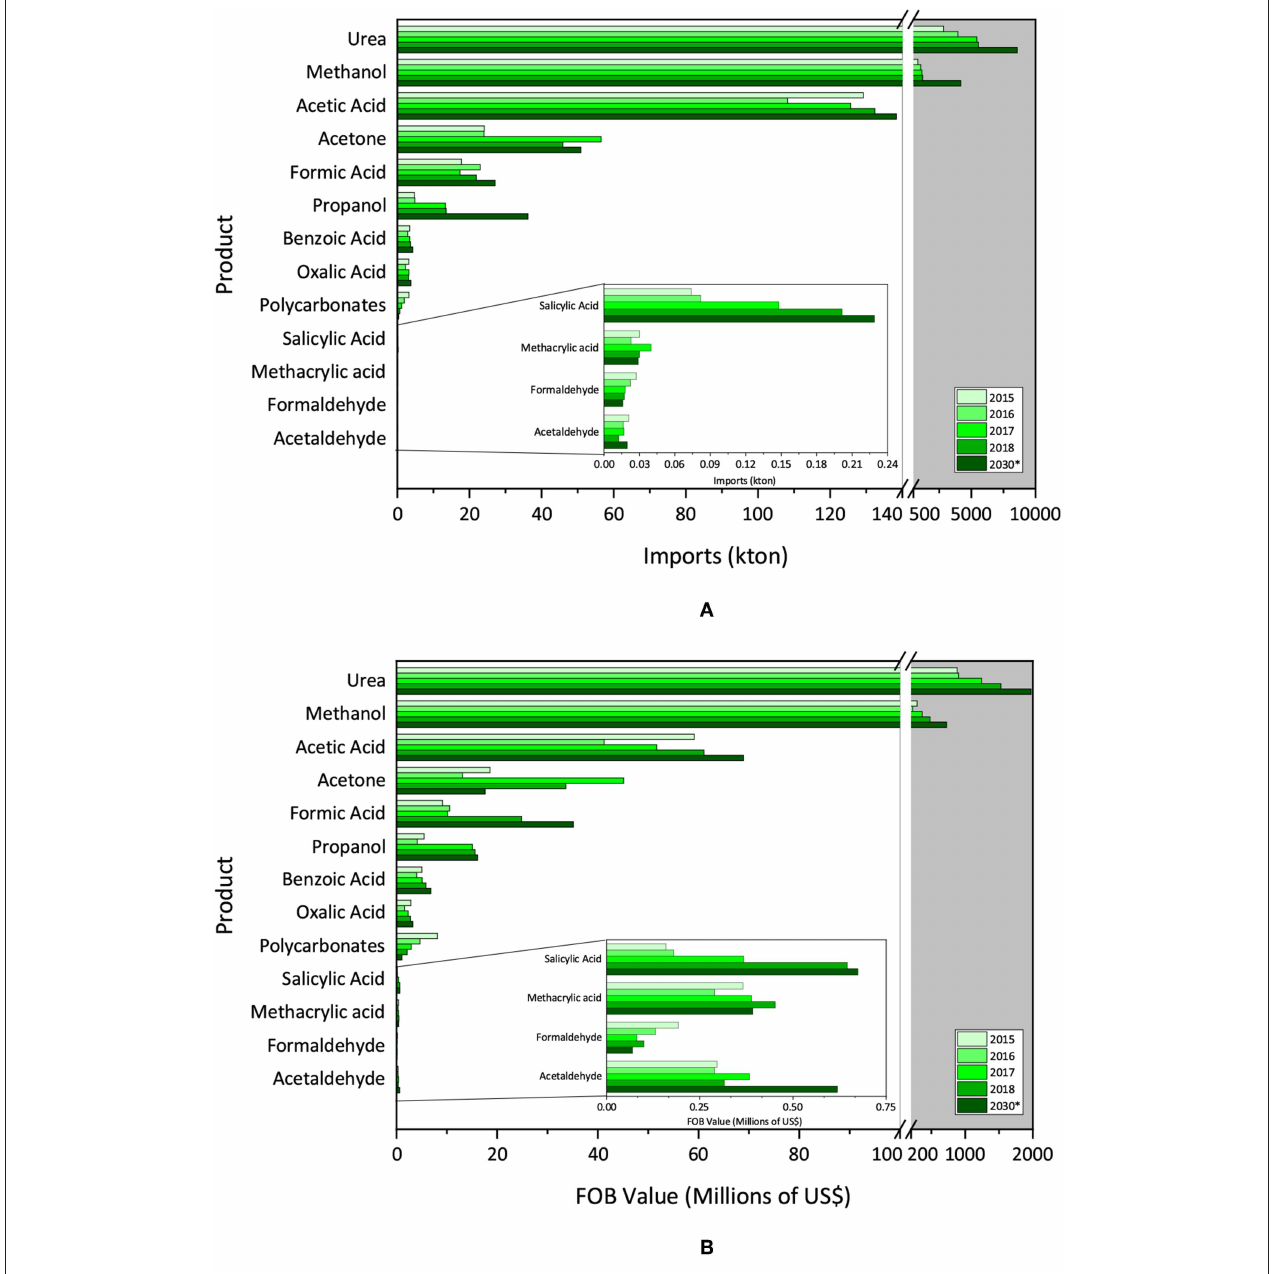
FIGURE 3 | (A) Brazilian importation data (absolute volume) and (B) Brazilian importation data (FOB